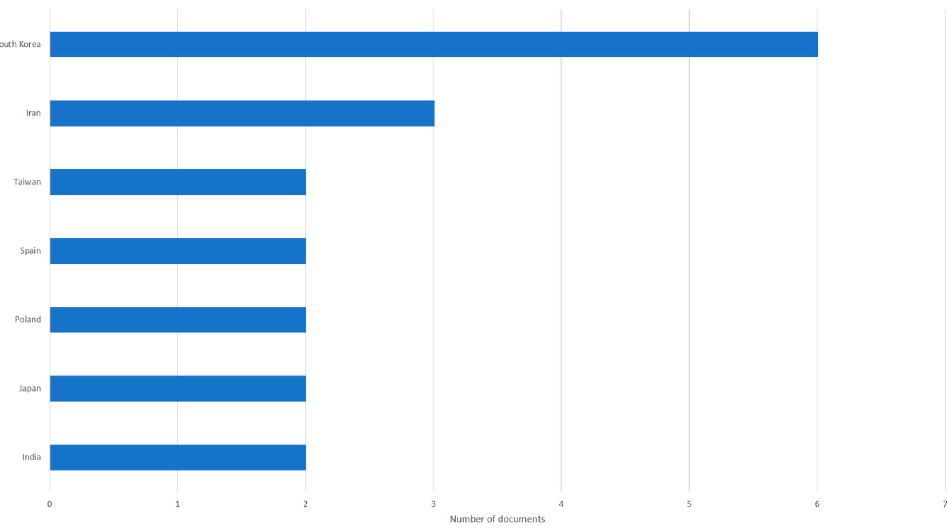
Figure 3. Documents by country or territory for pharmaceuticals and fucoxanthin (Appendix B—